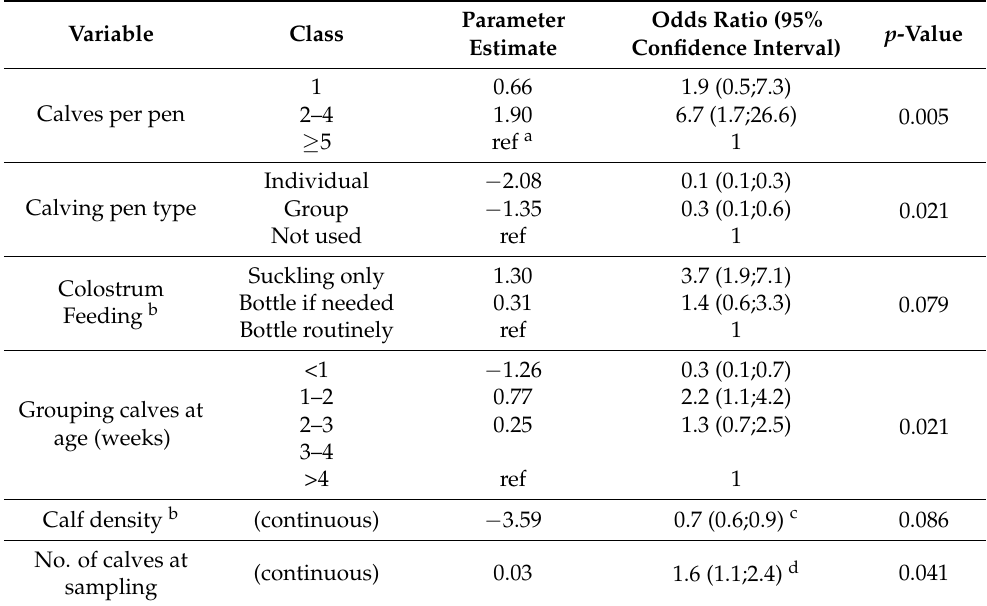
Table 5. Multivariable regression model of factors associated with diarrhea (Yes/No) in 250 preweaned